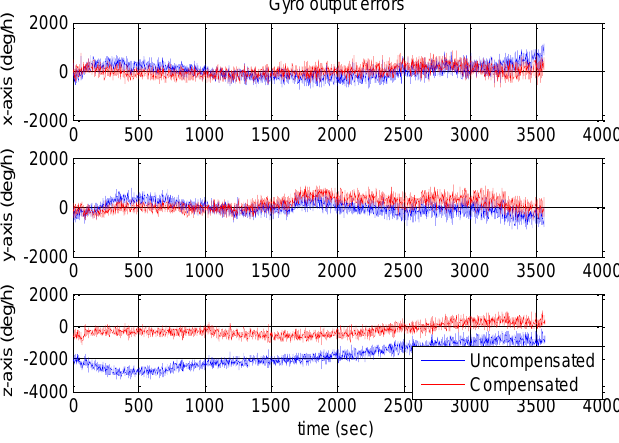
Figure 10. MTi-G gyro output errors with and without compensation.